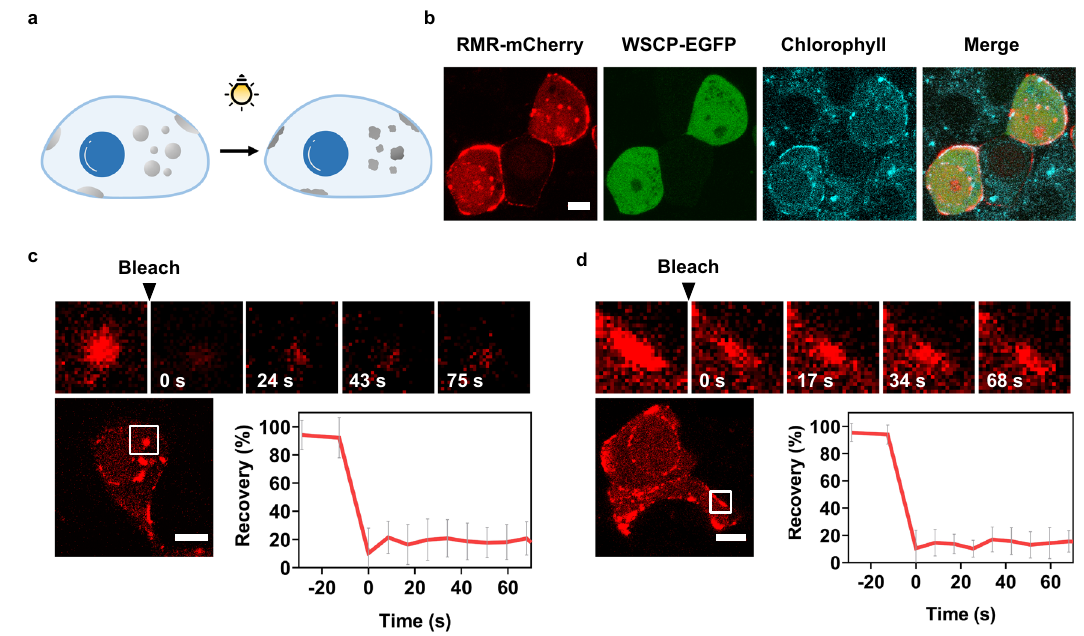
Fig. 9 Light-induced liquid-to-solid phase transition in HEK293 cells. a Schematic illustration of light-induced phase transition in cells. b Fluorescent images of the cells harbouring chlorophyll ( λ ex , 405 nm; λ em, 640 nm) while expressing RMR-mCherry and EGFP-WSCP. Scale bar: 10 μ m. Images representative of n = 5. FRAP assays of RMR condensates in the cytoplasm ( c ) and in the outer membrane of HEK293 cells ( d ). The plots show the recovery of the fl uorescence (normalized) after photobleaching. Scale bar: 10 μ m. Data are presented as mean ± SD ( n = 9 in c and n = 10 in d